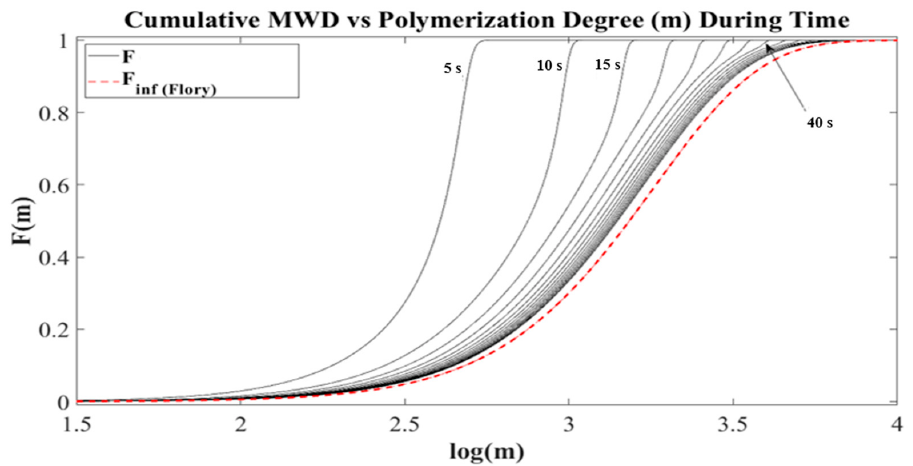
Figure 5. Cumulative molecular weight distribution according to Equations (36) and (37) ( K P = 100/s, K I = 1/s, K T = 0.1/s, K D = 0.01/s, t = 5 to 75 s by 5 s increments).